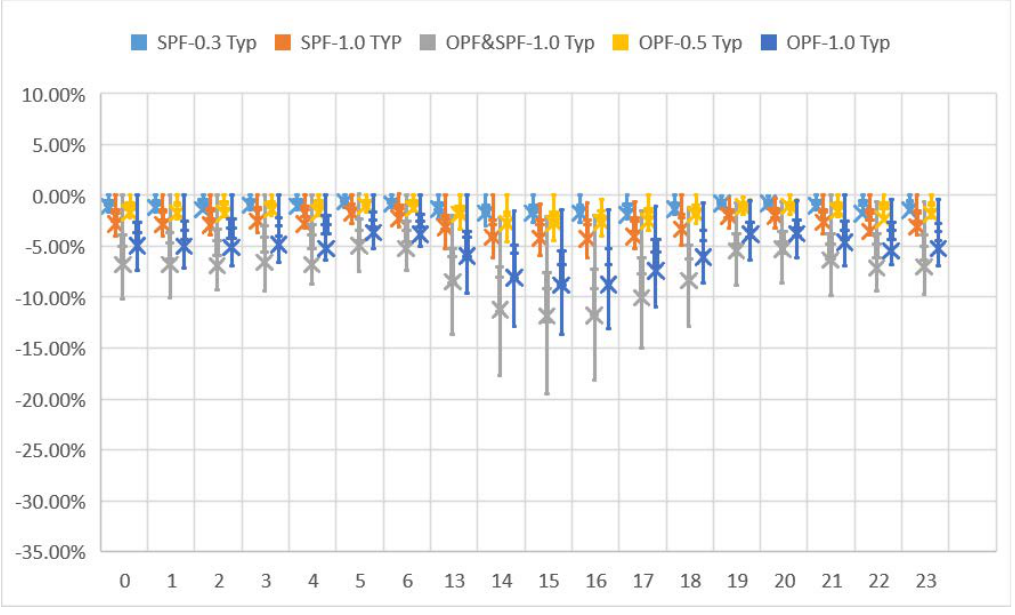
( e ) Box charts for hourly percentage difference in a year for tests for a Typical Floor, (1) Extended Side-fin at a length with Side-fin Projection Factor at 0.3; (2) Extended Side-fin at a length with Side-fin Projection Factor at 1.0; (3) Extended Side-fin and Overhang at a length with Side-fin Projection Factor at 1.0 and Overhang Projection Factor at 1.0; (4) Extended Overhang at a length with Overhang Projection Factor at 0.5; (5) Extended Overhang at a length with Overhang Projection Factor at 1.0. Figure A2. Annual percentage di ff erence distribution of cooling load vs. hours of days on typical floor. Figure A2. Annual percentage difference distribution of cooling load vs. hours of days on typical Note: The unit for the x-axis is %di ff , the unit for the y-axis is floor. Note: The unit for the x-axis is %diff, the unit for the y-axis is hour.